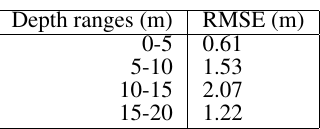
Table 5. SDB based CNN model accuracy over different depth ranges.